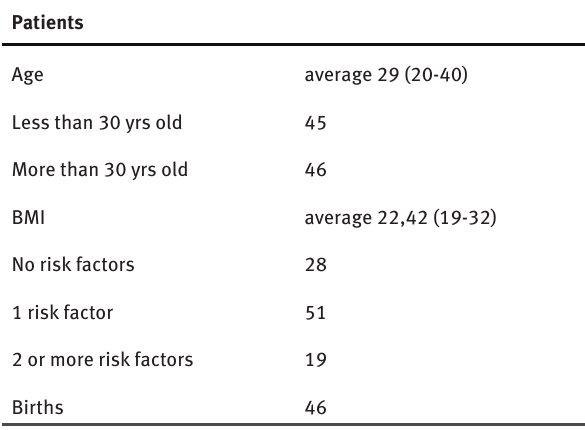
Table 1: Patients